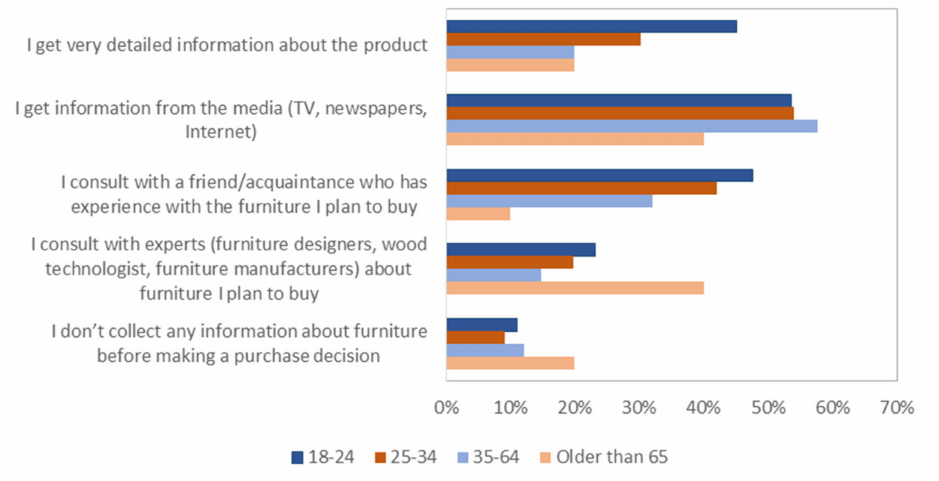
Figure 3. Consumer ways of collecting information regarding age ( N =